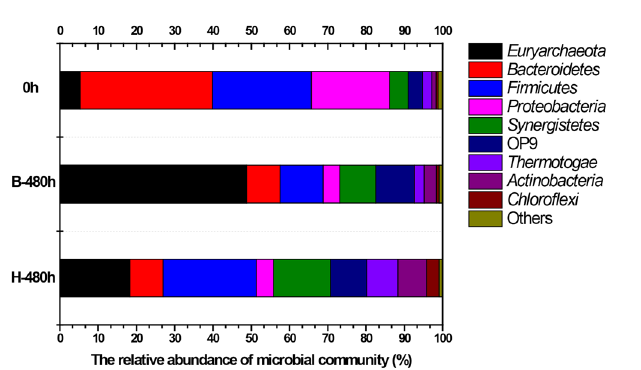
Table 1. Effective DNA sequences, richness and alpha diversity from bacterial and archaeal communities analysis. a Chao 1 richness estimator: a higher number represents higher richness. b Shannon index (H): a higher value indicates more diversity.